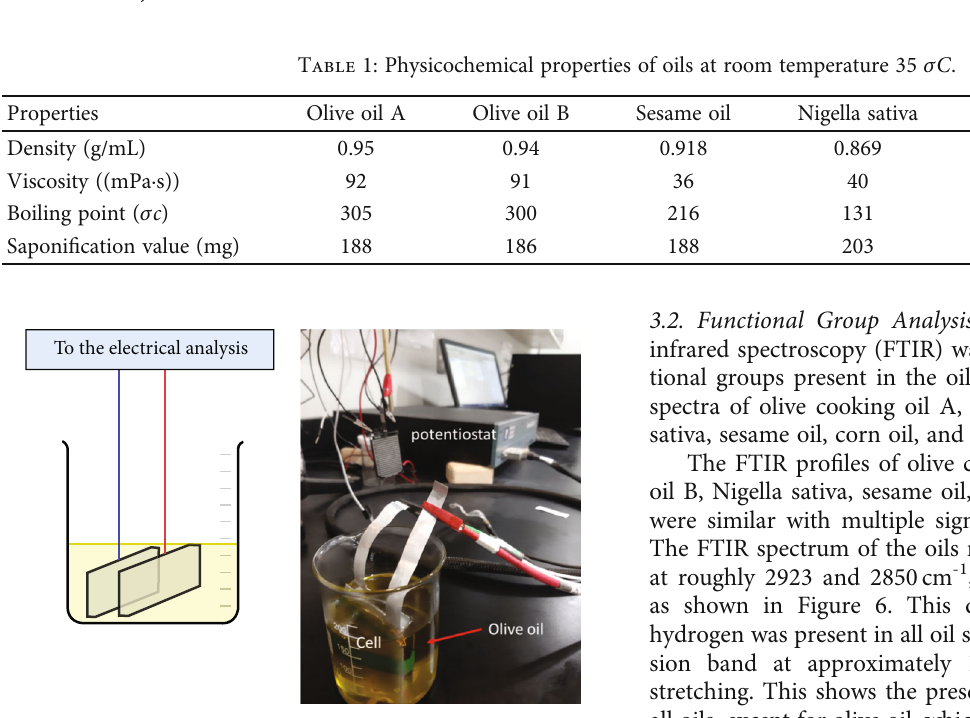
Figure 2: Illustration of the proposed olive oil dielectric constant measurement